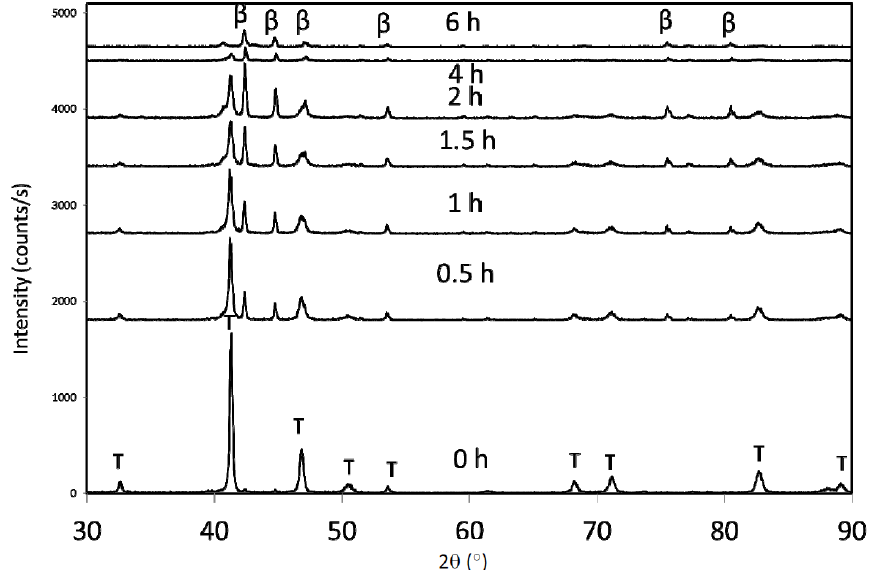
Figure 4. X-ray diffraction patterns for ε-milled samples after conversion from ε to